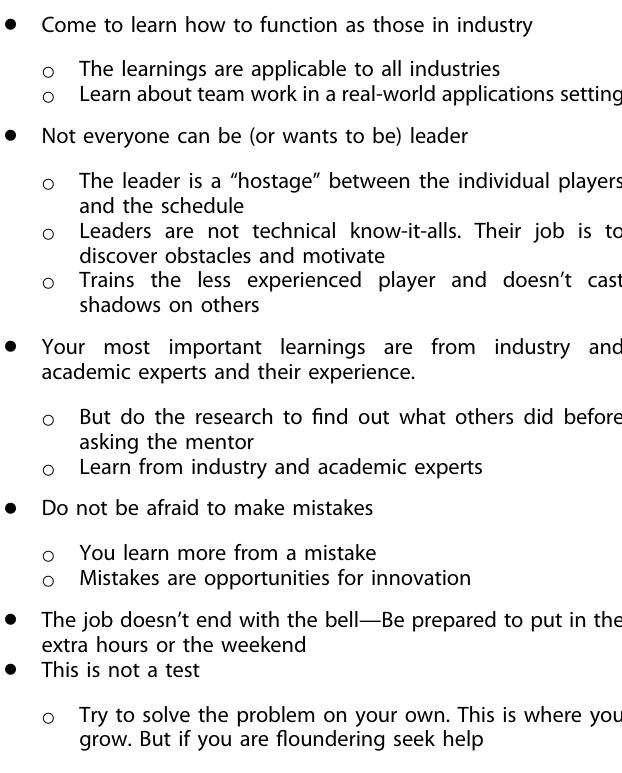
Table 4. Engineering vs. classroom environments Engineering is not the same as classroom — not everyone gets the same experience Create a Gantt chart schedule, track regularly and adjust Use action lists to track short-term tasks, not the overall schedule or Gantt chart Set expectations and regularly show progress and owners Use rapid prototyping for early problem discovery and Innovation Hold individuals